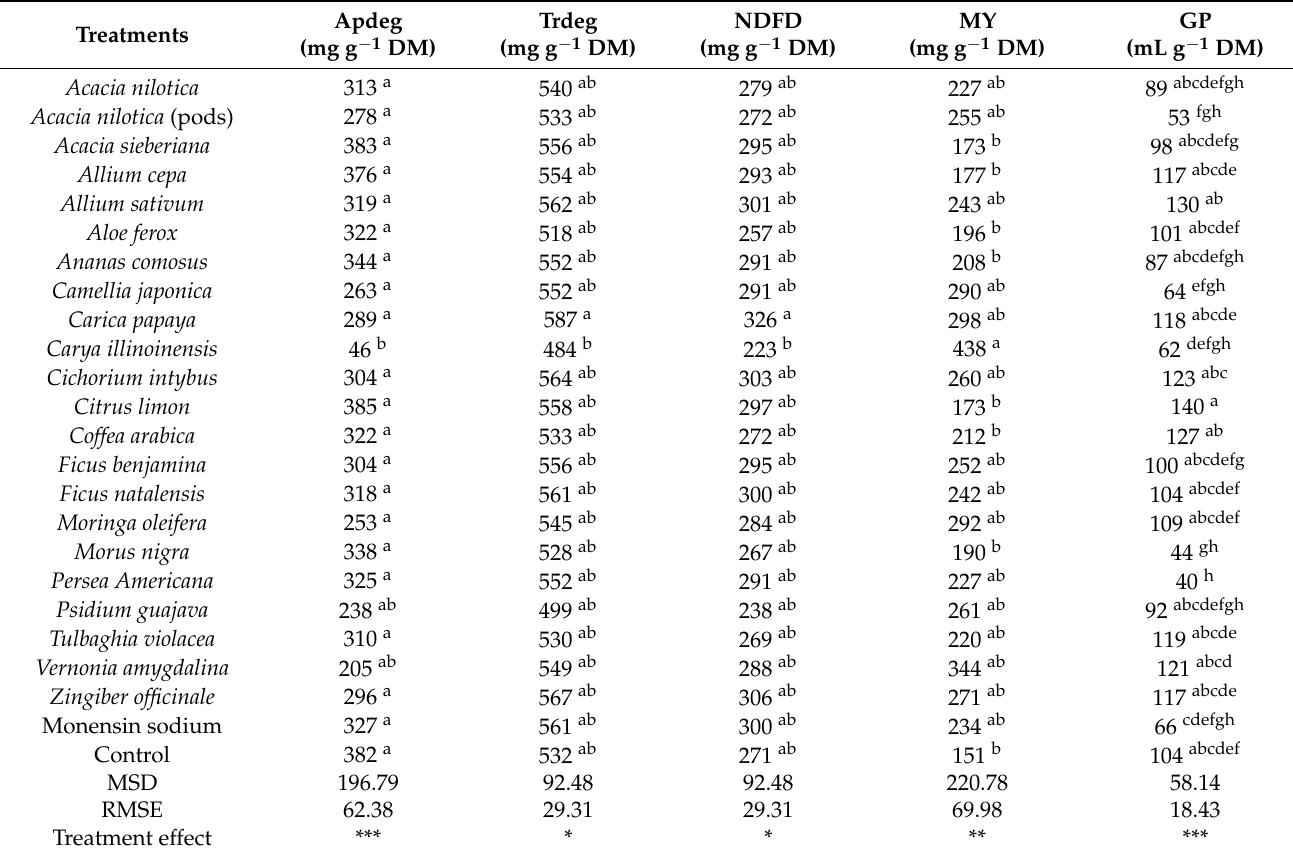
Table 3. Degradability and gas production of Themeda triandra hay as influenced by the inclusion of plant extracts rich in phytochemicals and monensin at 48 h of fermentation in